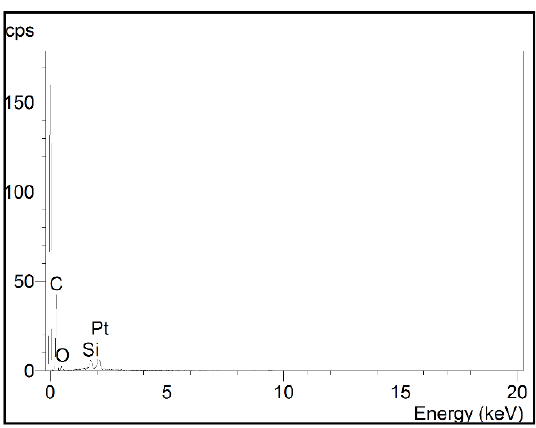
Figure 3. EDX spectrum of POSS-grafted PU nanomatrix.